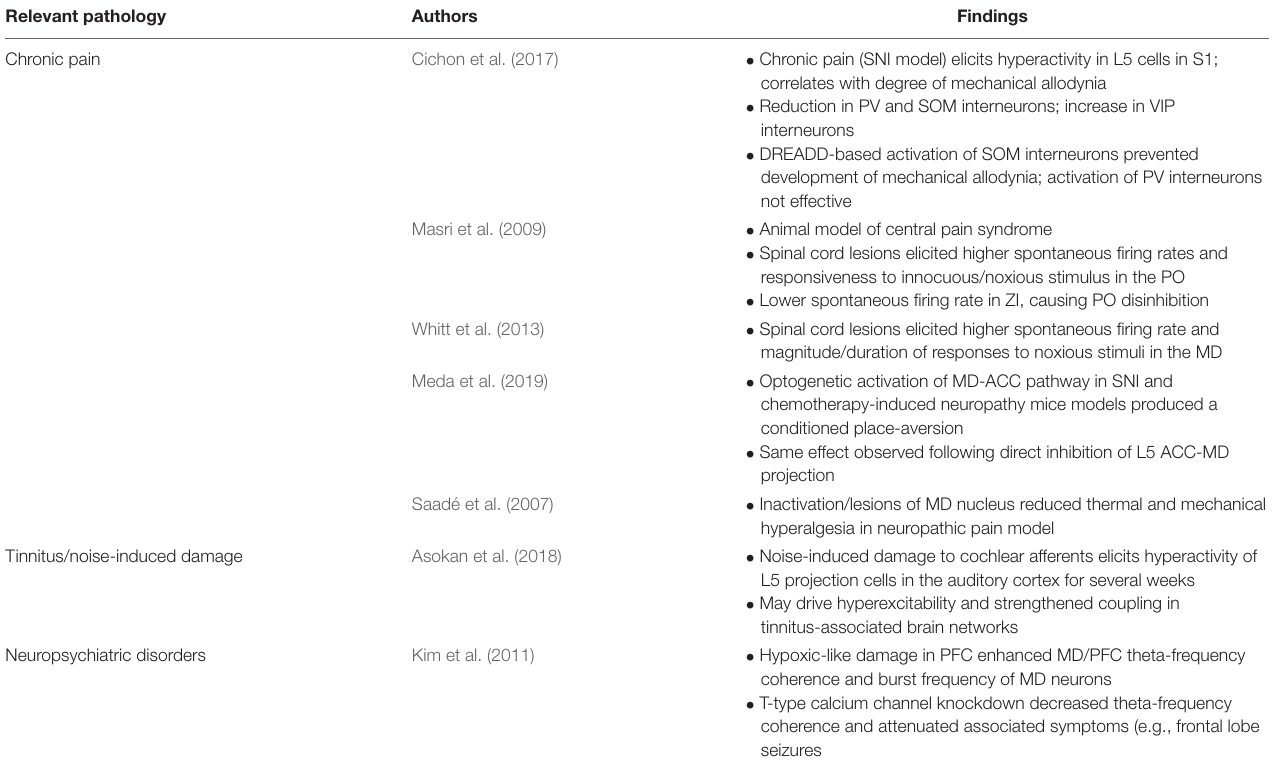
TABLE 2 | Summary of key literature findings on the relevance of higher-order CTC pathway components across pathological states including pain, tinnitus, and neuropsychiatric